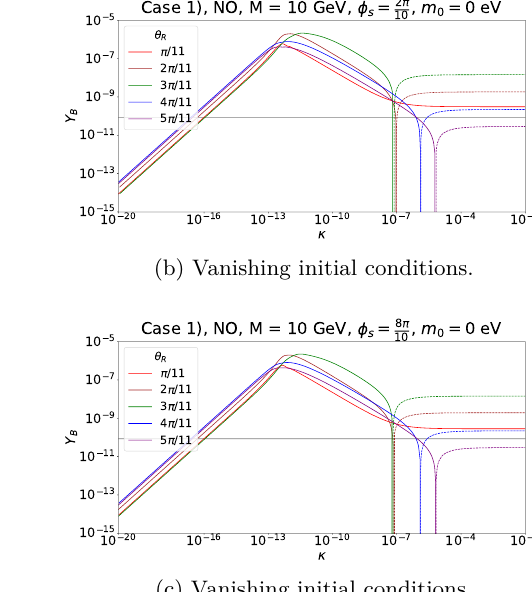
Figure 6 . Case 1) Y B as function of κ for M = 10 GeV and different values of φ s , φ s ∈ π For the remaining choices see figure 4.